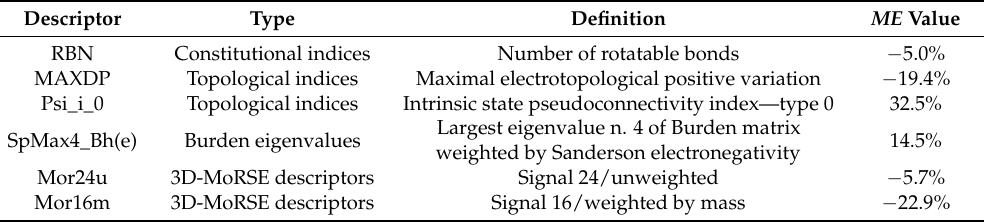
Table 3. Descriptors selected for the best model for prediction of